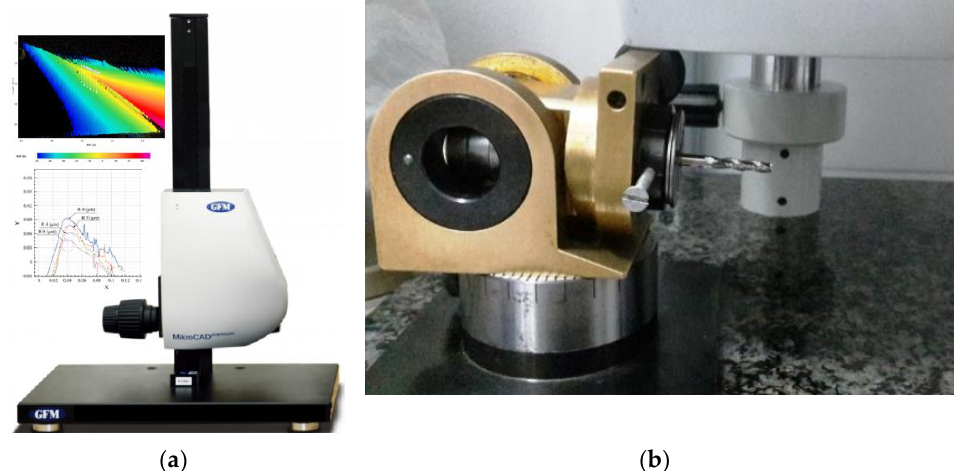
Figure 3. Optical measuring system MikroCAD premium+ manufactured by GFMesstechnik GmbH ( a ) and a 3-mm-diameter end mill installed under the system ( b ).